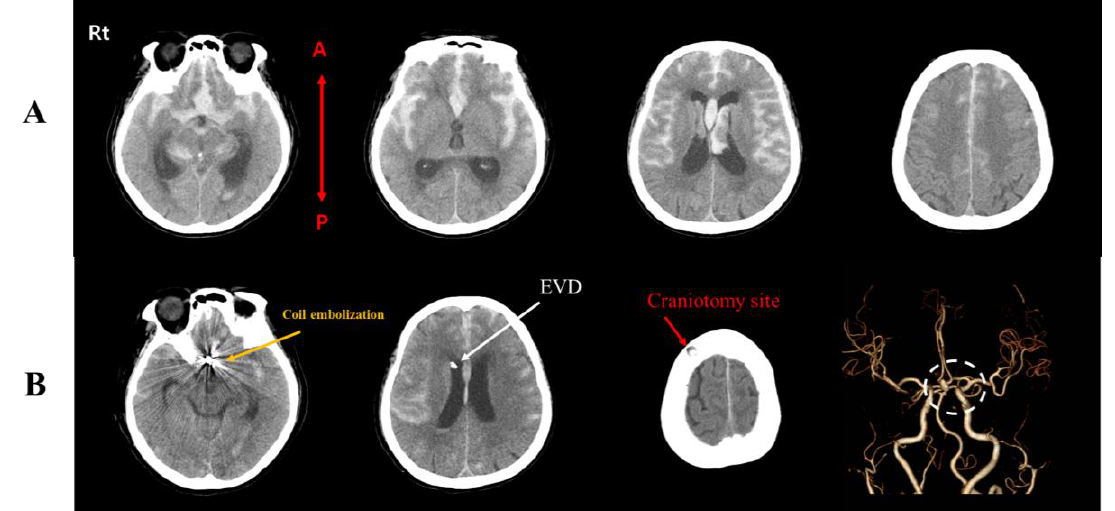
Figure 1. ( A ) Initial computed tomography (CT) images showing subarachnoid hemorrhage (SAH) with intraventricular hemorrhage (IVH) and consecutive ventriculomegaly, resulting from a ruptured anterior communicating artery aneurysm (ACoA). ( B ) CT image after coil embolization and external ventricular drainage (EVD) placement. Coil embolization (yellow arrow), EVD (white arrow), craniotomy site at the right frontal lobe (red arrow), and ACoA (white dashed circle). Note: EVD; external ventricular drainage, R, right; L, left; A, anterior; P, posterior.